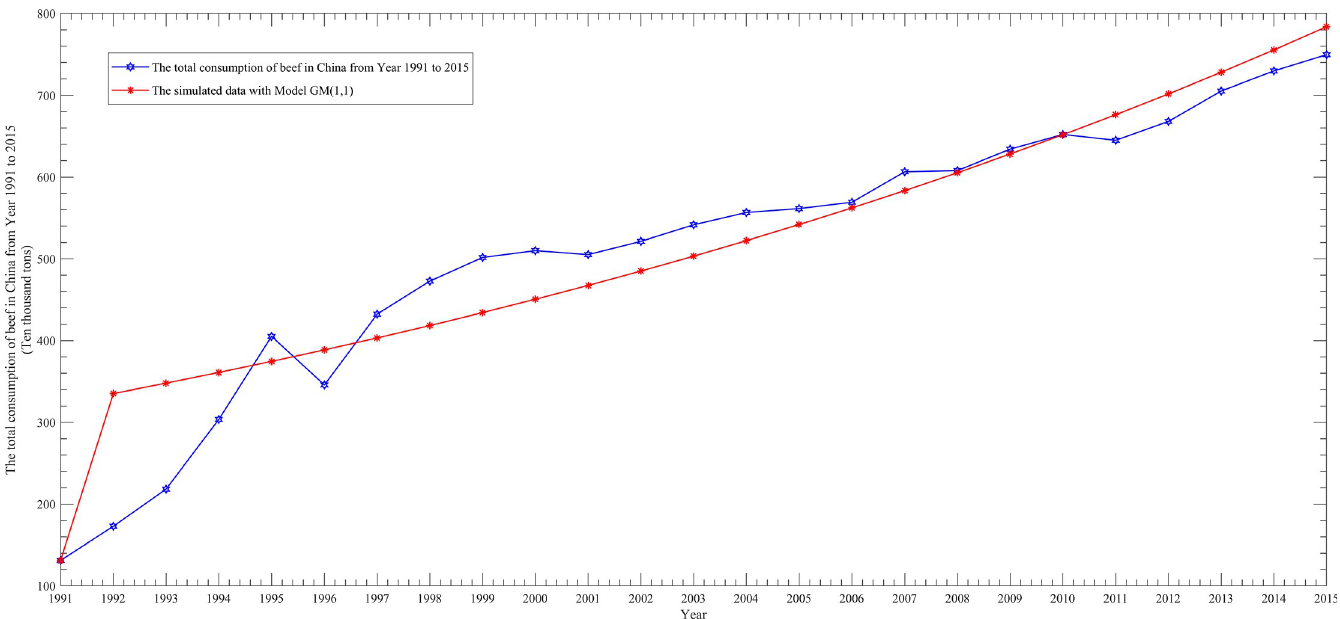
Fig 3. Curves of the actual data and simulated data of the GM(1,1)model.